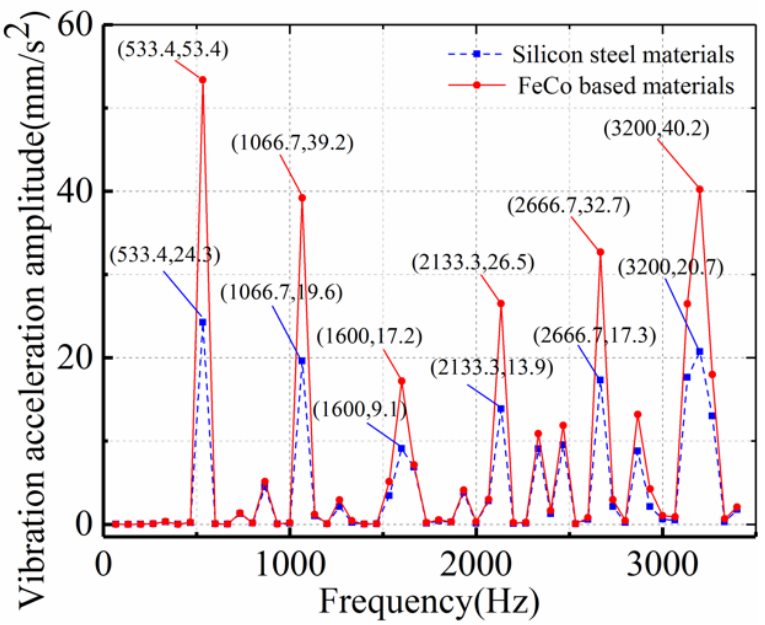
Figure 6. Comparison curve of vibration acceleration frequency spectrum of different materials.